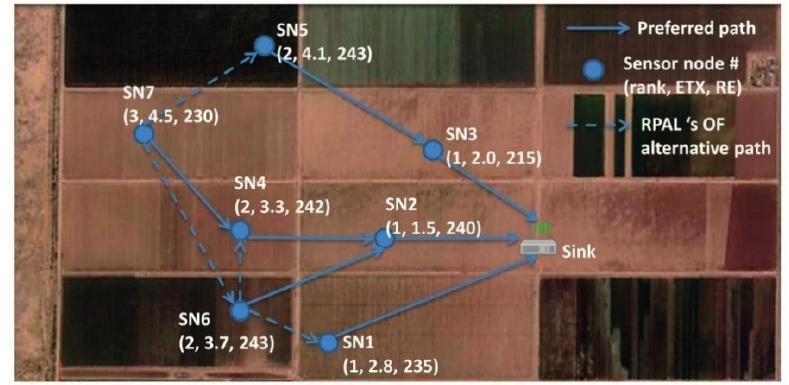
Figure 1. A-LLN scheme. SN2 has to forward the messages from SN4, SN6, and SN7 to the sink. Consequently, it will become inactive due to the hotspot issue.